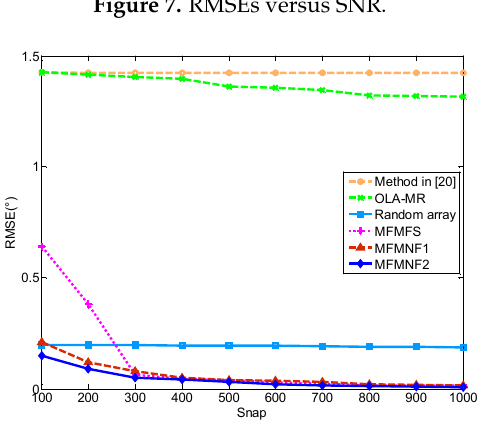
Figure 7. RMSEs versus SNR.